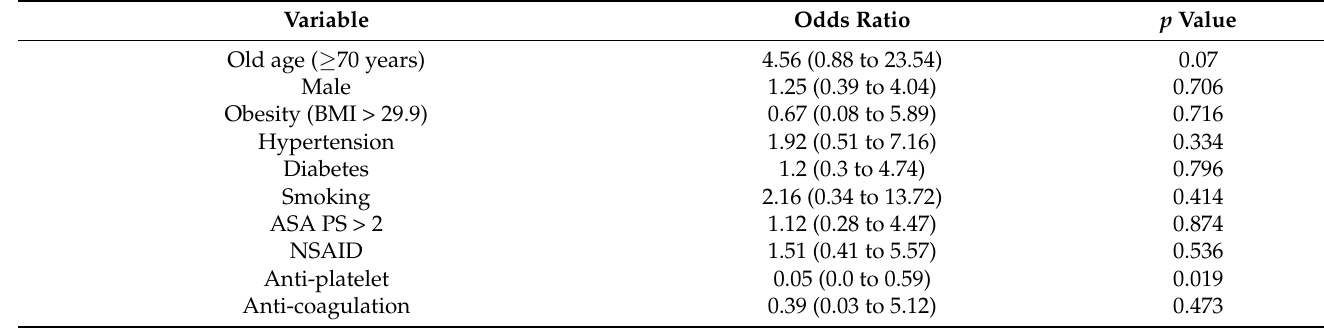
Table 3. Adjusted odds ratio for postoperative symptomatic lumbar epidural